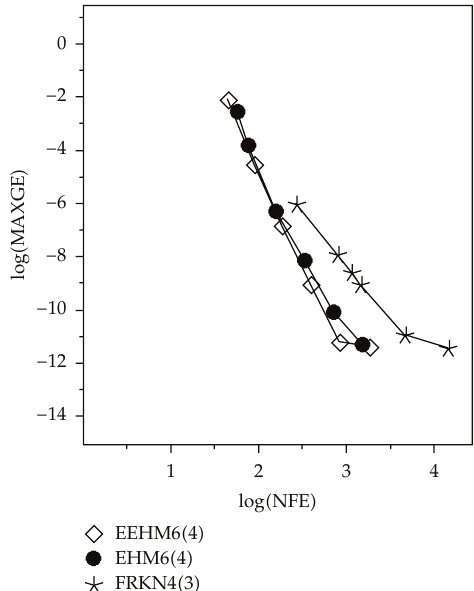
Figure 6: E ffi ciency curves for Problem